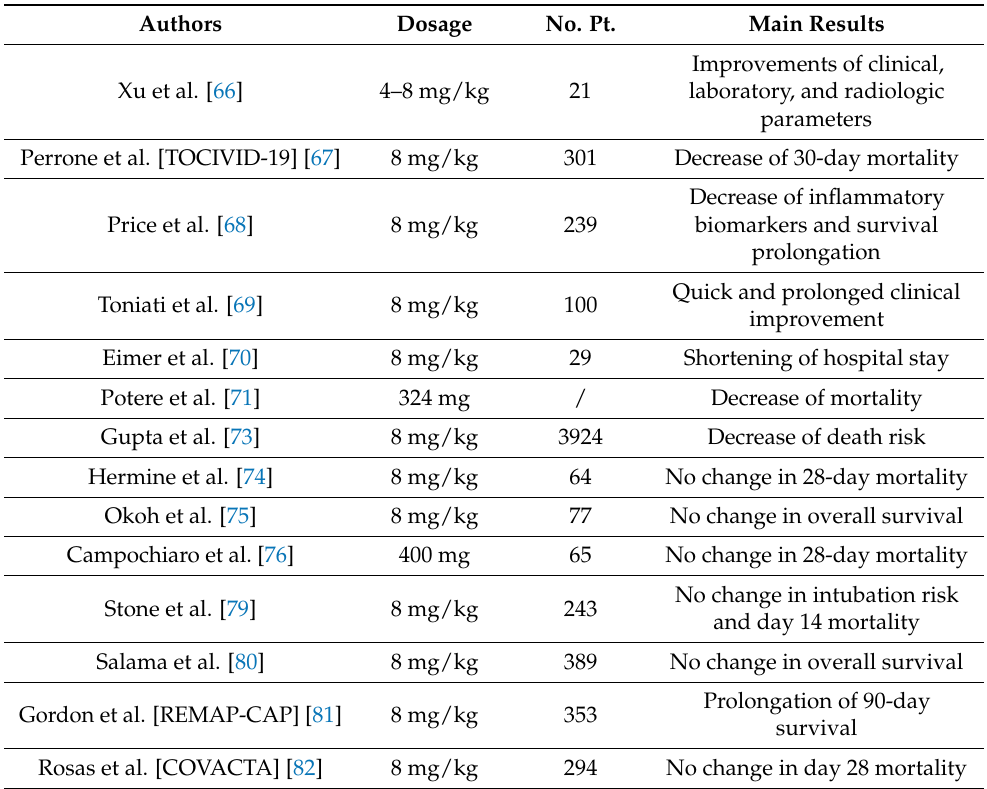
Table 1. Summary of the main studies evaluating tocilizumab for treatment of critically ill COVID- 19